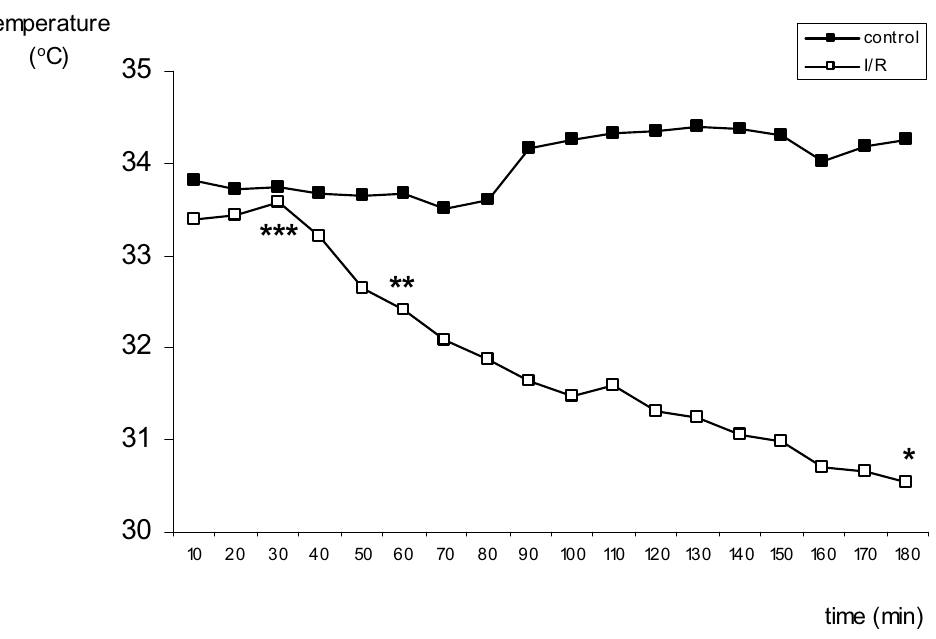
FIGURE 6 – Mean esophageal temperature (oC) along time. Asterisk indicates significant differences according experimental time in I/R group (p <